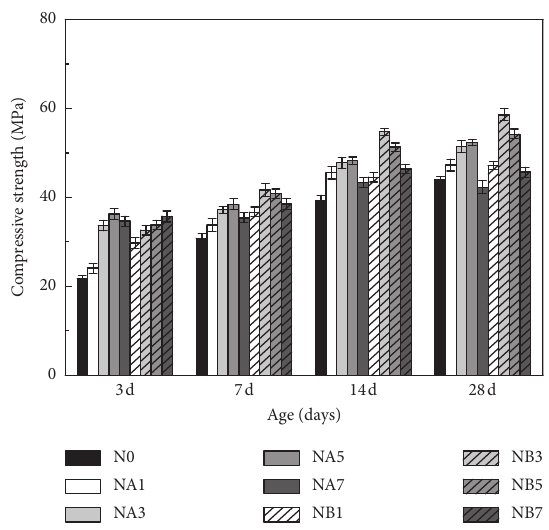
Figure 7: Compressive strength of the HCS samples at various curing periods.